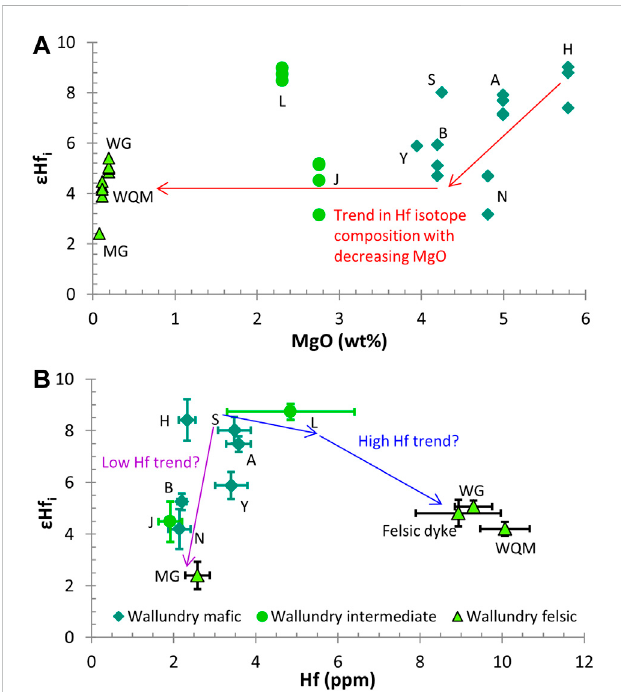
FIGURE 11 Magma-melt relationships for the simple mixing of basaltic melt with bulk incorporation of a partially melted sediment. (A) Relationships between mixing endmembers in SiO 2 -Hf isotope space. Overall the mixture is between basalt and the sediment ( “ Source ” ). The sedimenthasameltcomponentthatcanmixwiththebasalticmelt.Two different possible melts (connected to the bulk-sediment by the “ source-melt lines ” ) are shown along with the two different “ melt mixing lines ” that show the composition of the mixed melt at increments that match those of the overall magma mixing. The compositions of the sedimentary components are modelled by applying the disequilibrium melting approach of Iles et al. (2018) to biotite dehydration (Vielzeuf and Holloway, 1988) of a metapelite (Bea and Montero, 1999). These relationships generate negative Δε Hf i magma-melt values (mostly) because the sediment is much less radiogenic than the basalt and the mixed magma contains both solid (contaminant restite) and melt components of the sediment whereas the mixed melt only contains the melt component. Note that for very high fractions of sediment in the magma mixture of the second melt case ( Δε Hf source-melt = − 0.2, 41% melt) the Δε Hf i magma-melt values are very small negative values. (B) For the two different melt cases, the relationship between the Hf isotope composition of the magma and its melt is shown, relative to a 1:1 line. Notethatthemaximumdifferencesbetween magmaandmeltareatthe intermediate degrees of